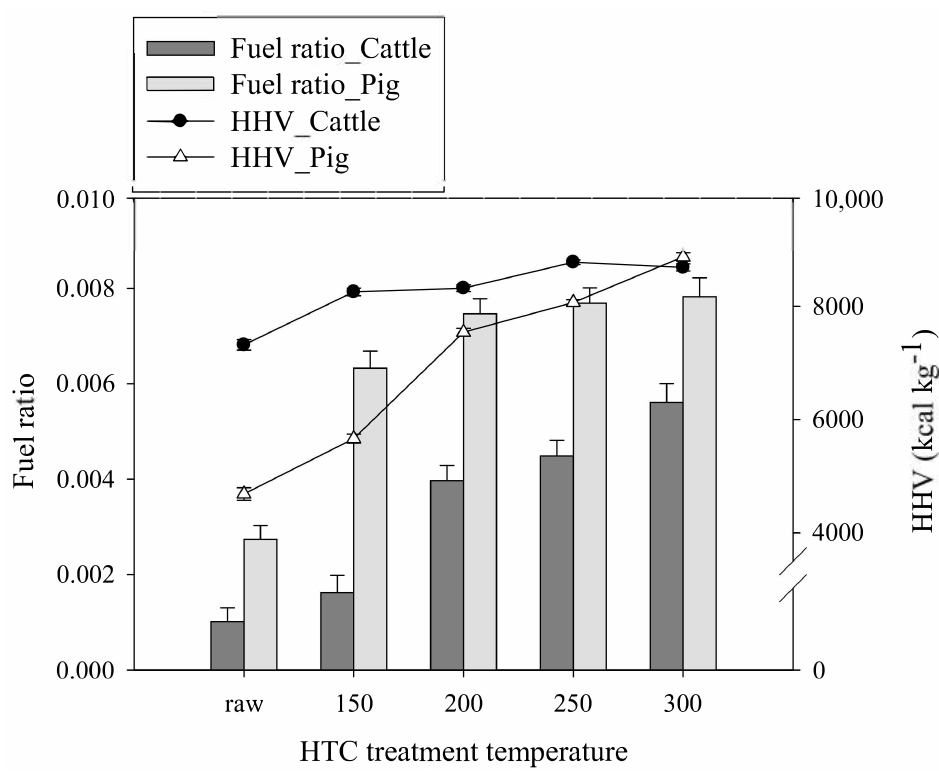
Figure 2. Fuel ratio and HHVs of the cattle and pig SHWs and hydrochars. The shift in the coalification degree during HTC was evaluated using the van Krevelen diagram, which compares the aromaticity (atomic H/C ratio) and the polarity (atomic O/C ratio) of the samples (Figure 3).